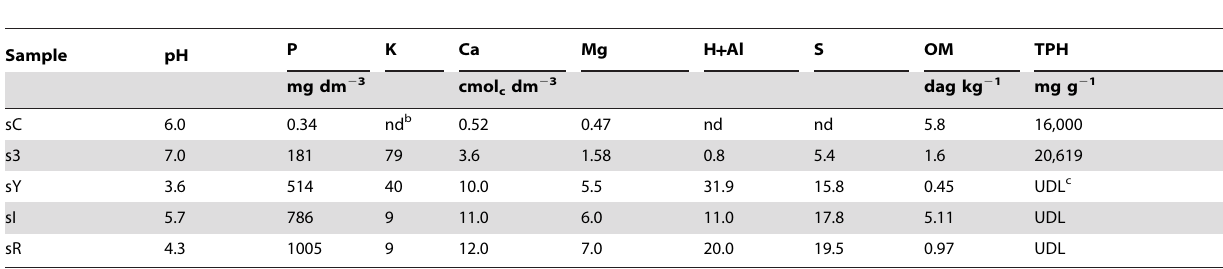
Table 3. Chemical and physicochemical properties of the soils from Carmo´polis, Brazil and King George Island in Maritime Antarctica a